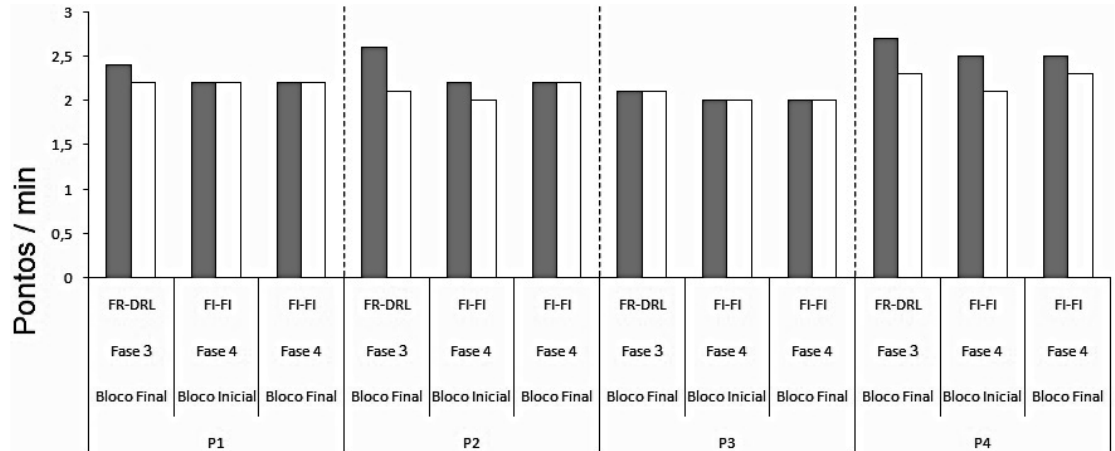
Figura 2. Taxas médias de pontos obtidos (em pontos por minuto) para cada participante, em cada componente do múltiplo FR-DRL, nas últimas quatro sessões da Fase 3 (Bloco Final), em cada componente do múltiplo FI-FI nas primeiras quatro sessões da Fase 4 (Bloco Inicial) e nas últimas quatro sessões da Fase 4 (Bloco Final).